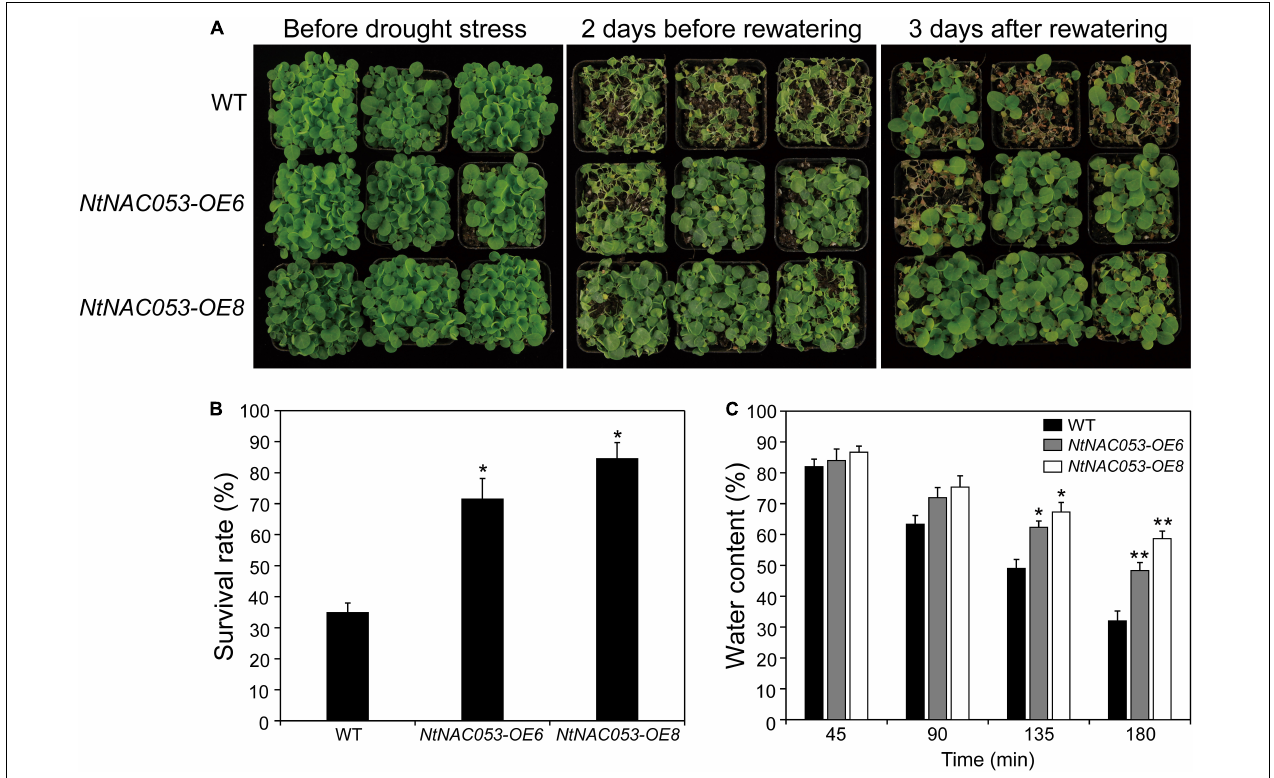
FIGURE 7 | Drought tolerance assay of transgenic NtNAC053 tobacco. (A) Phenotypes of overexpression lines and wild-type tobacco under drought stress. Under normal conditions, the overexpression lines and wild-type tobacco were normally grown for 6 weeks. Overexpression lines displayed higher drought tolerance after 10 days of drought stress and 3 days of recovery. (B) The survival rate of the overexpression lines and wild-type tobacco were determined. (C) The water content of detached leaves of overexpression lines and wild-type tobacco. WT, wild type. The data were means ± SD from three independent replications. * p < 0.05, ** p < 0.01 ( t -tests).